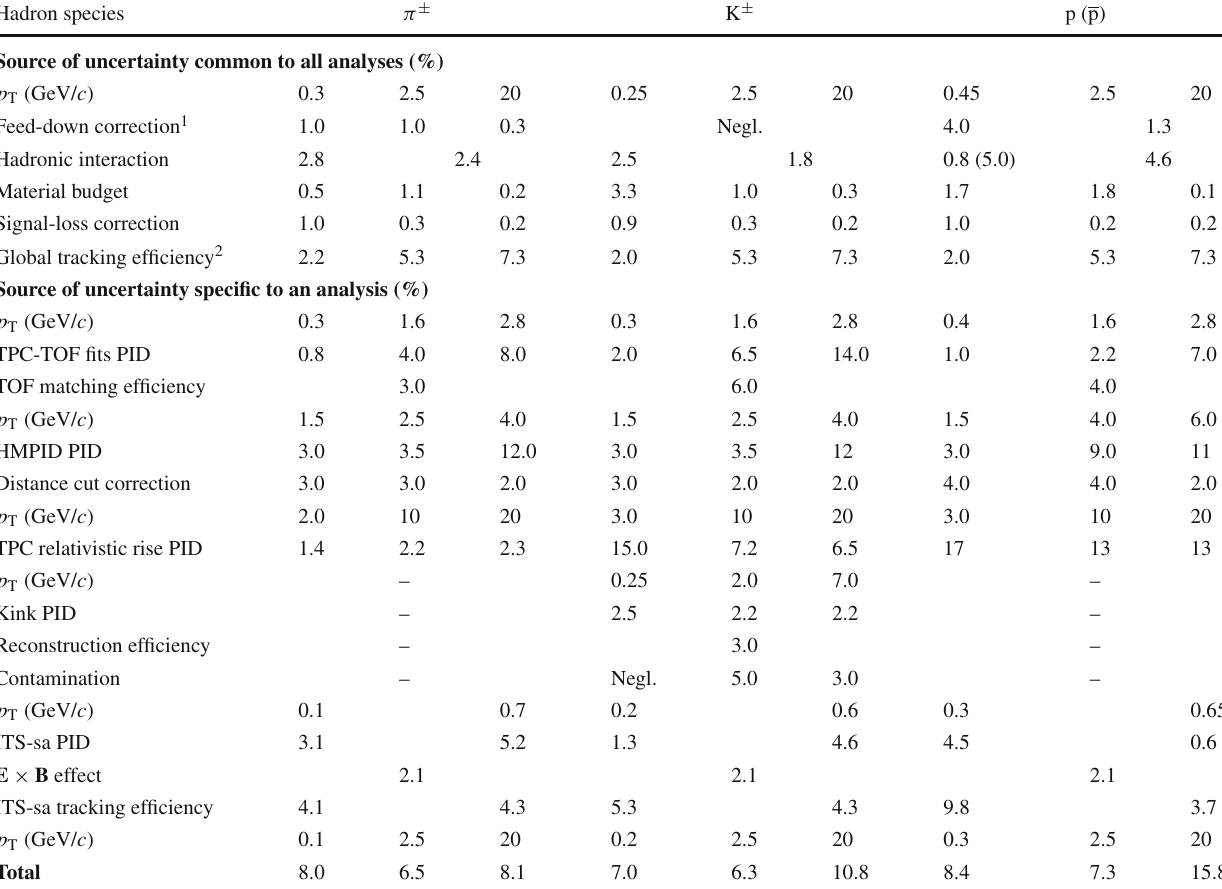
Table 3 Summary of the main sources and values of the relative sys- tematic uncertainties (expressed in %) for the π + + π − , K + + K − , and p + p p T -differentialyields.Asinglevaluebetweentwoorthreecolumns